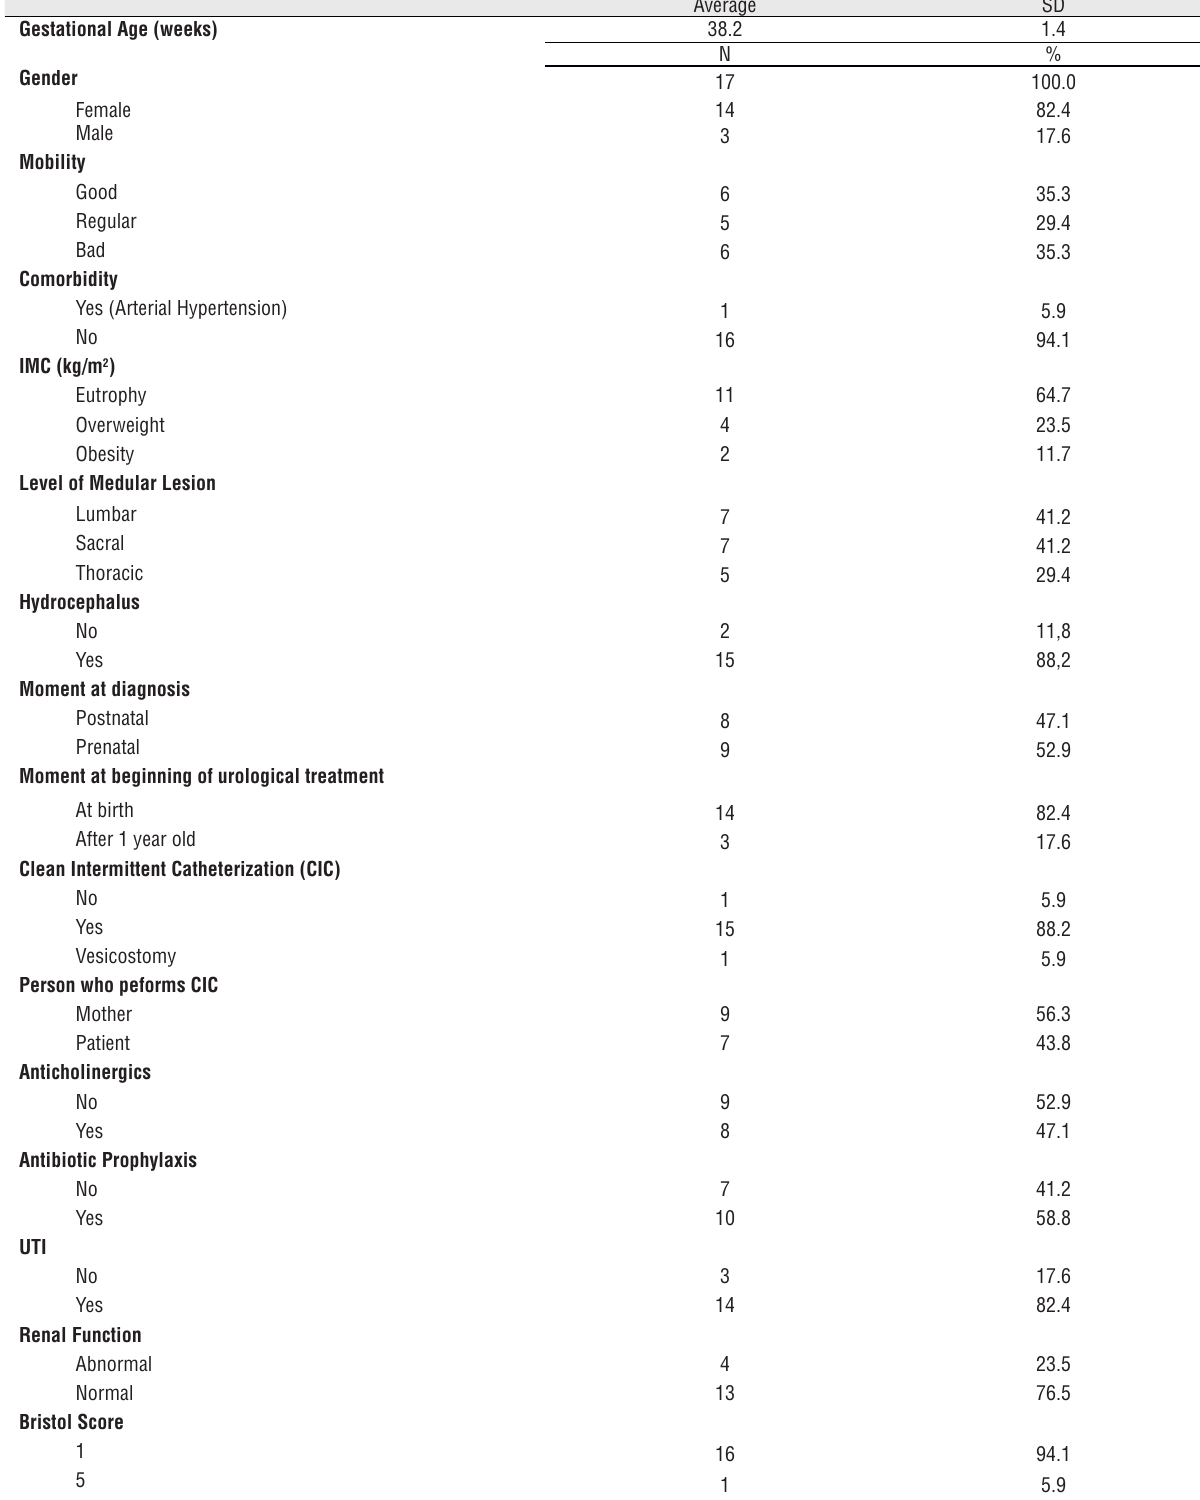
Table 1 – Clinical aspects in Study Group